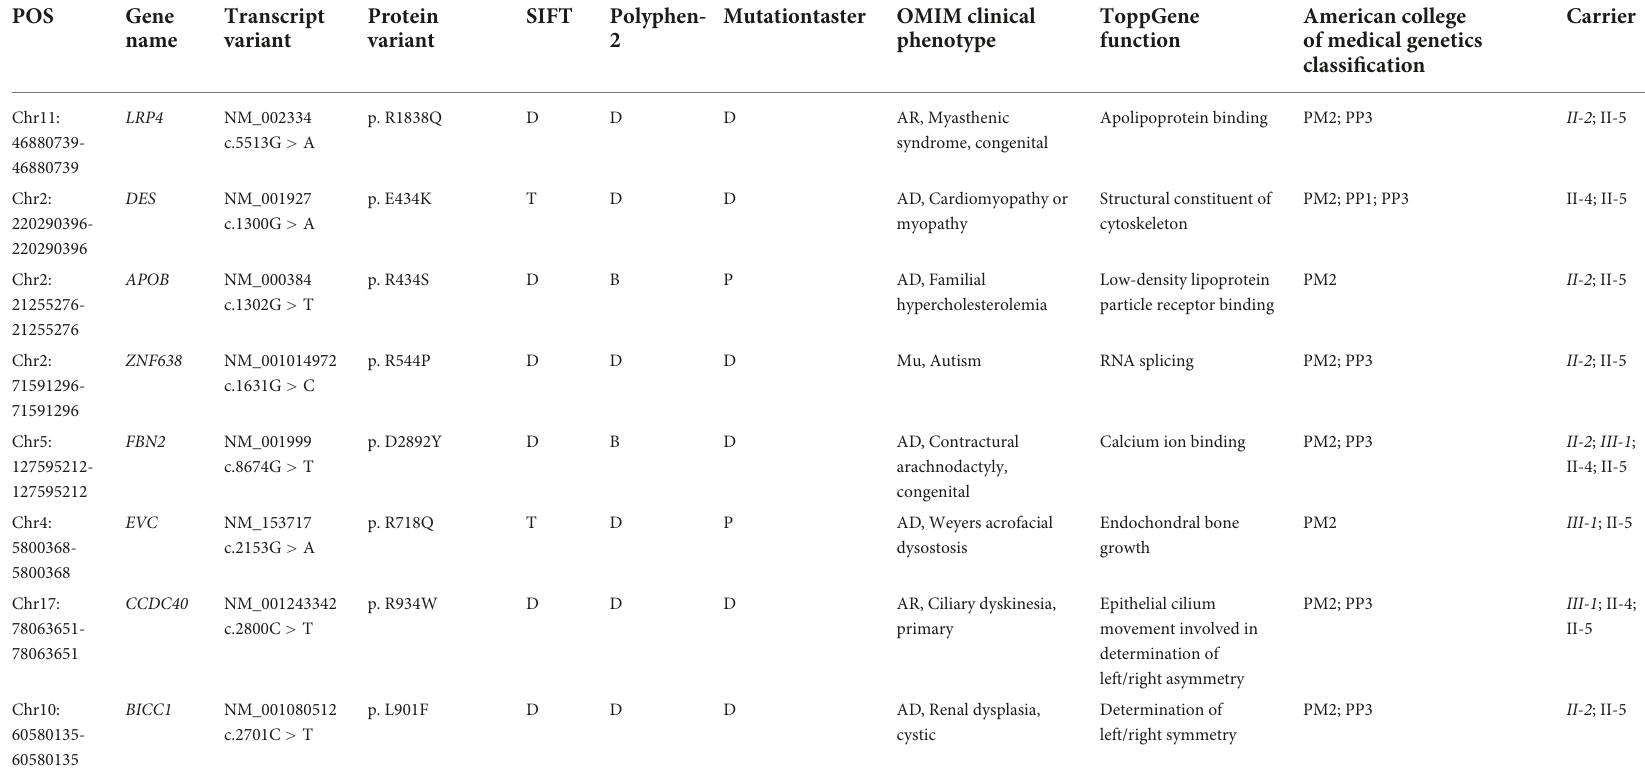
TABLE 2 Variants identified by WES in this